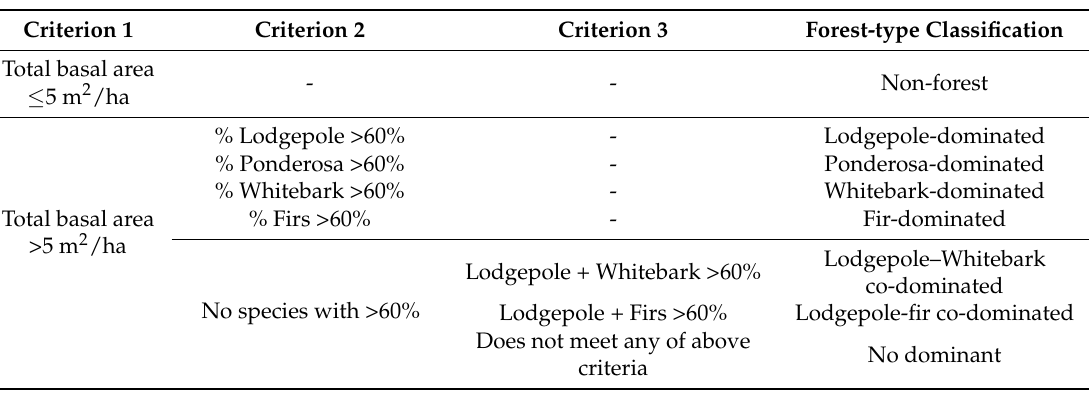
Table A1. Criteria for forest-type classification based on 30-m gridded basal area estimates for lodgepole pine, ponderosa pine, whitebark pine, and fir